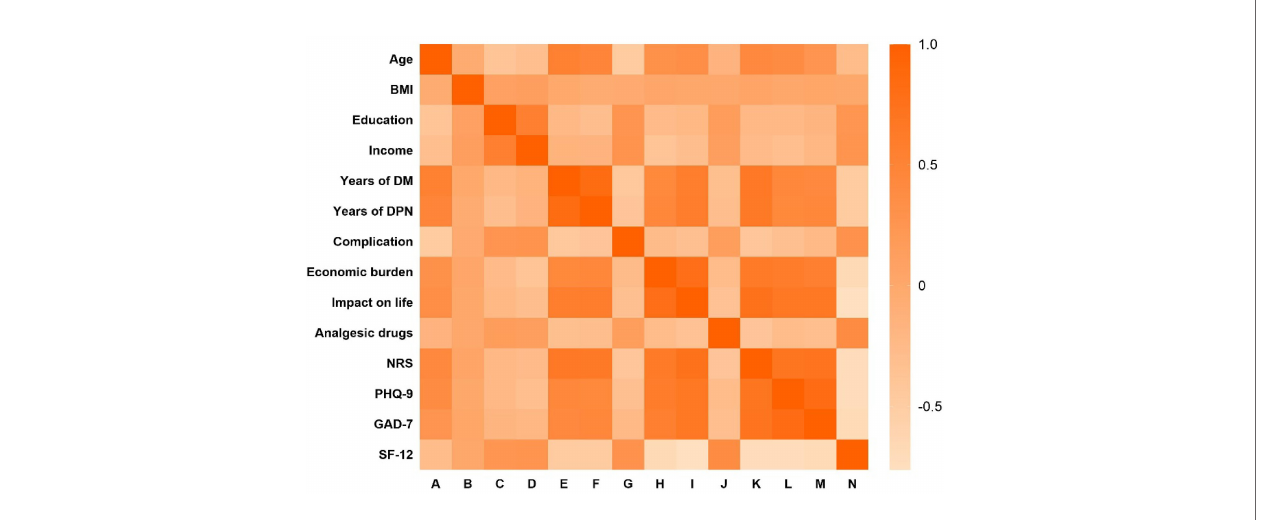
FIGURE 3 | Heat map of the correlation between NRS scores and different factors.